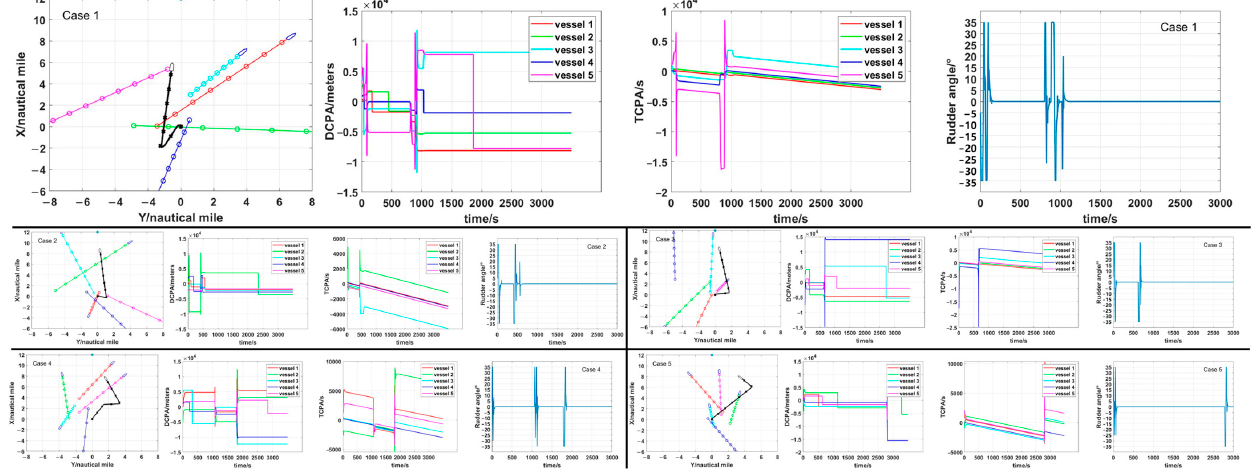
Figure 19. Test samples in generated virtual scenarios of 5 target ships encounter. There are 5 cases illustrated in the plots (case 1 in the larger graphs, other cases in the smaller graphs), in each case, the DCPA, TCPA and rudder angle changings are also added.